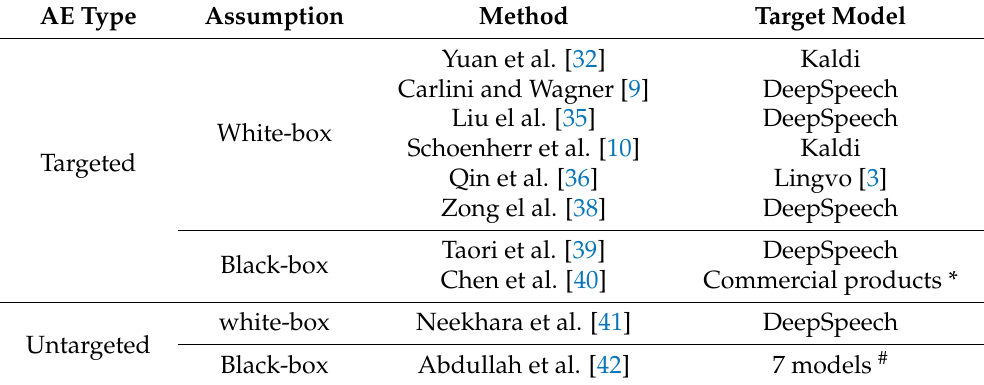
Table 1. A summary of research efforts on audio AEs in ASR